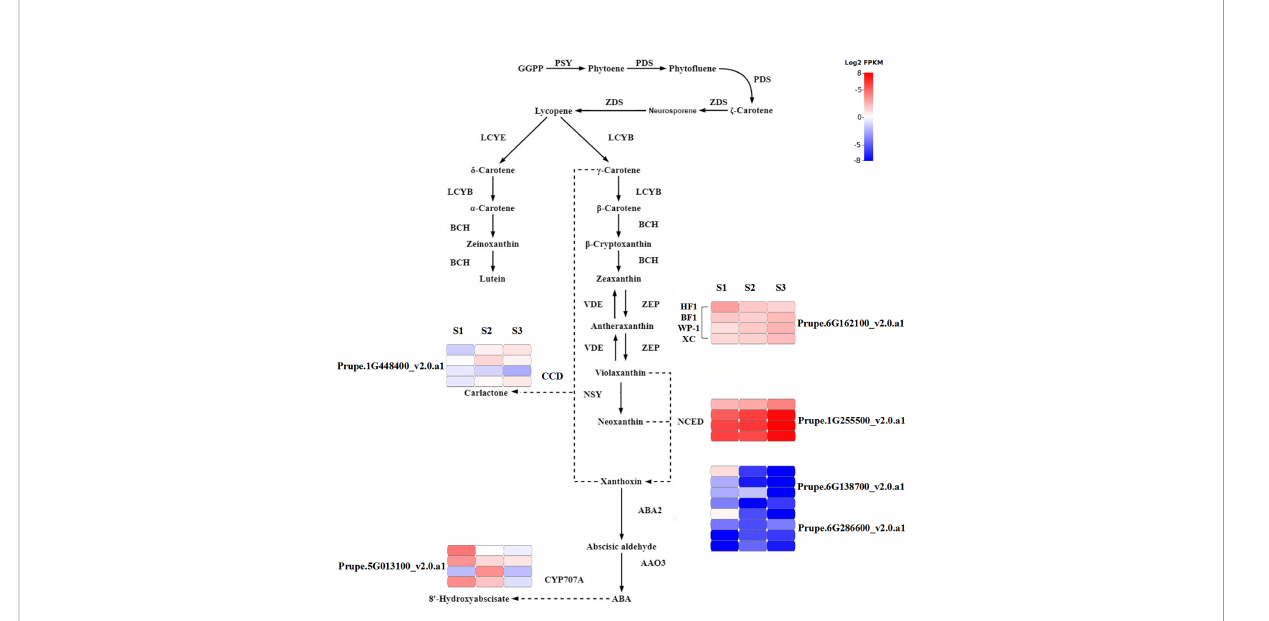
FIGURE 6 Changes in gene expression levels mapped to carotenoid metabolism was shown of BF1 and HF1 at fruit development